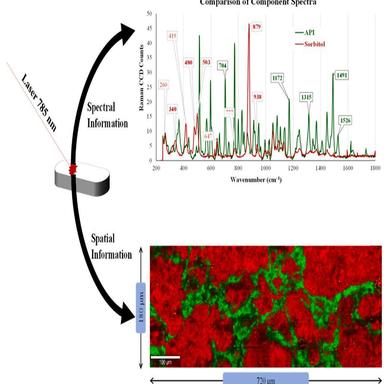
Sample preparation, comparison of Raman Spectra of components in the chemical image, and image analysis for spatial location of components.